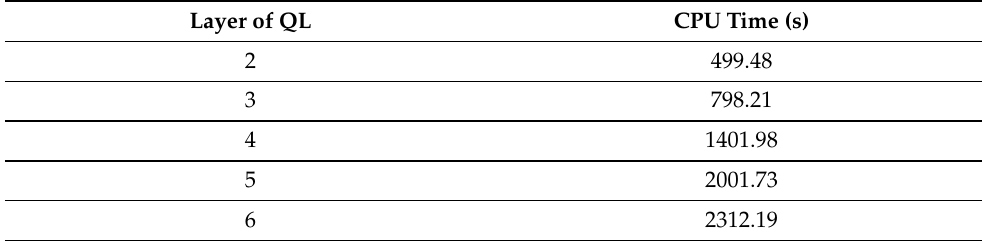
Table 4. Training time for different layers of